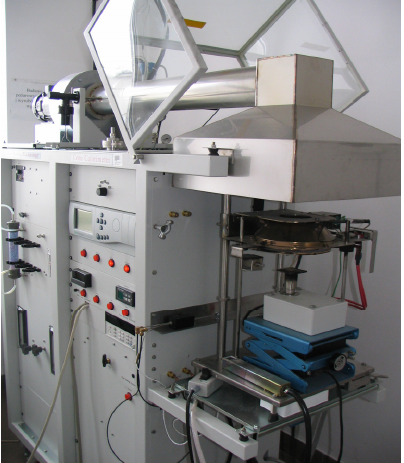
Fig. 2. A view of the cone